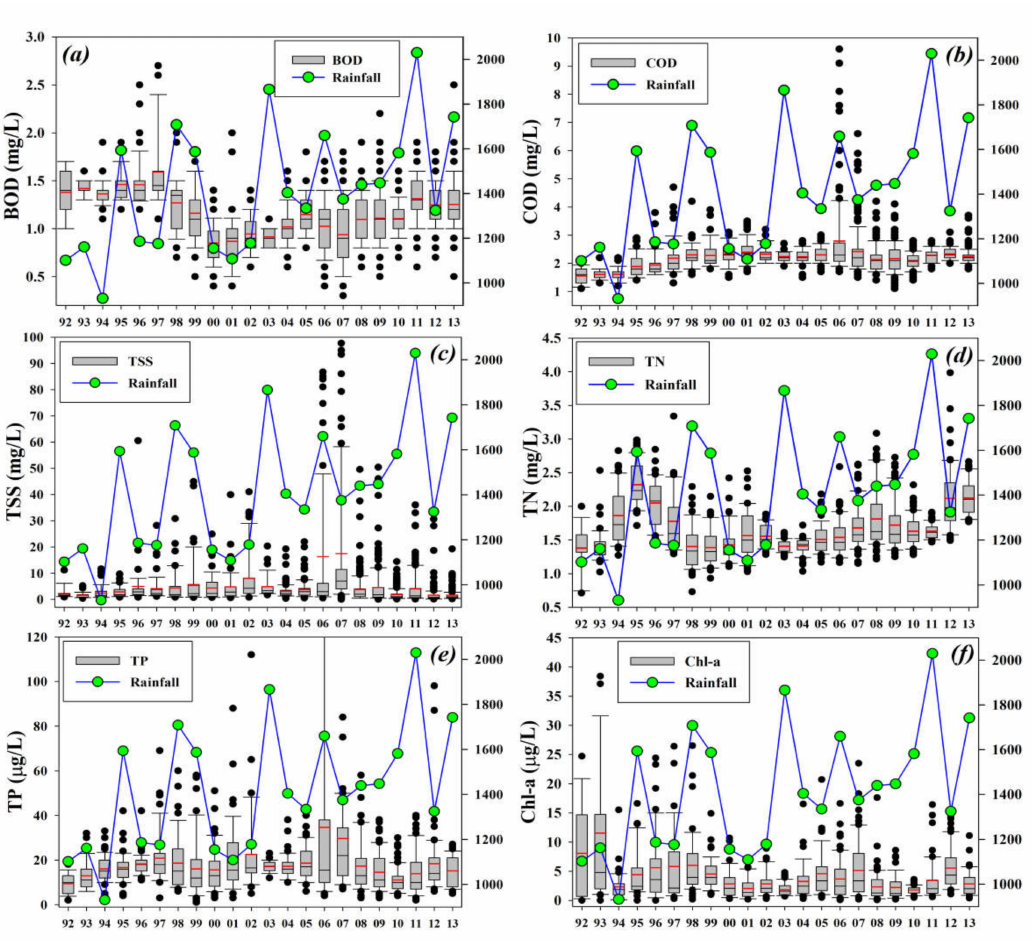
Figure 3. Interannual fluctuations in the selected water chemistry parameters ( a ) BOD, ( b ) COD, ( c ) TSS, ( d ) TN, ( e ) TP, ( f ) Chl-a, with annual rainfall (mm) intensity in the Soyang reservoir watershed during 1992–2013. The right-hand y-axis indicates rainfall intensity